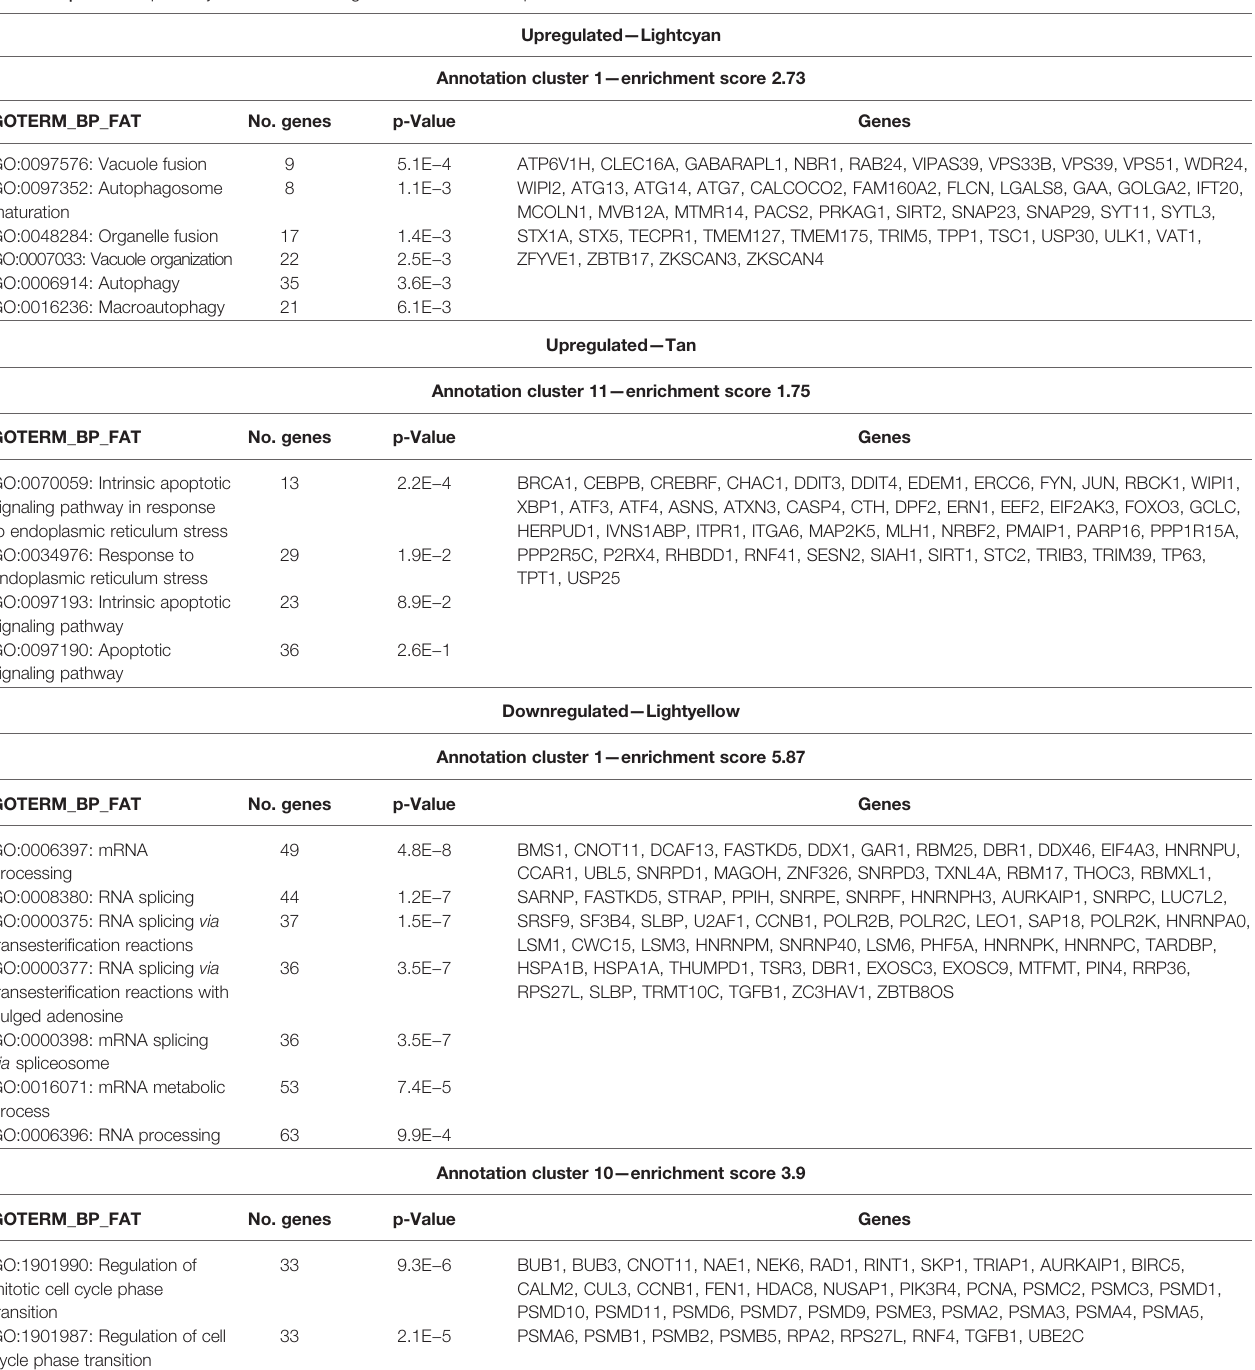
TABLE 1 | Enriched pathways relevant to the signi fi cant modules of experiment 1.